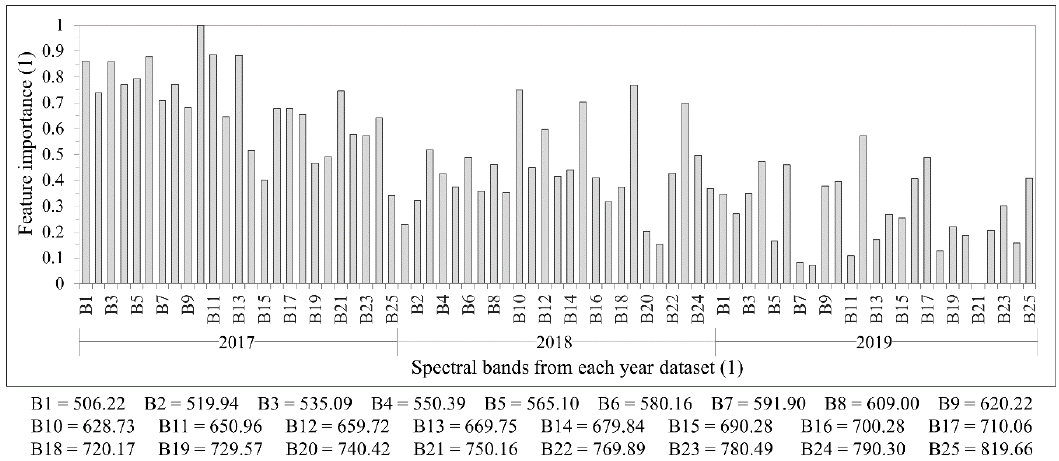
Figure 10. Feature importance when using the RF for 8 tree species and all datasets (Dall_MeanNorm). The x-axis represents the spectral bands in each year. Wavelengths in nm.